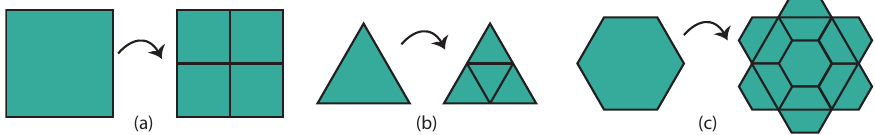
Figure 4. One-to-four refinements for quadrilateral ( a ), triangular ( b ) and hexagonal cells ( c